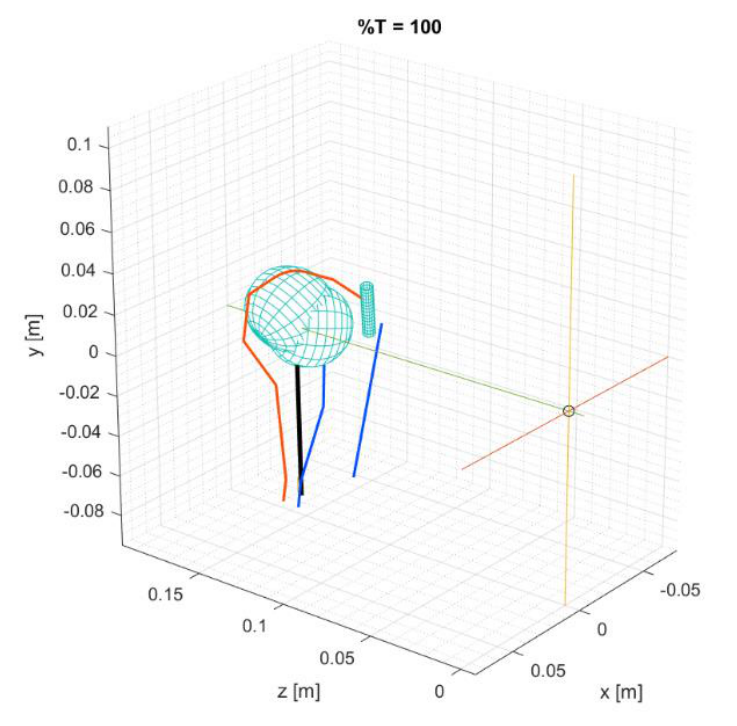
Figure 10. Shoulder